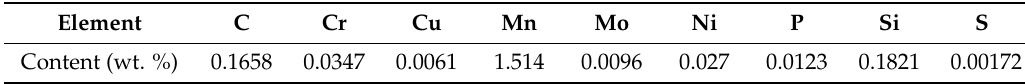
Table 1. Chemical composition of DP800 steel.